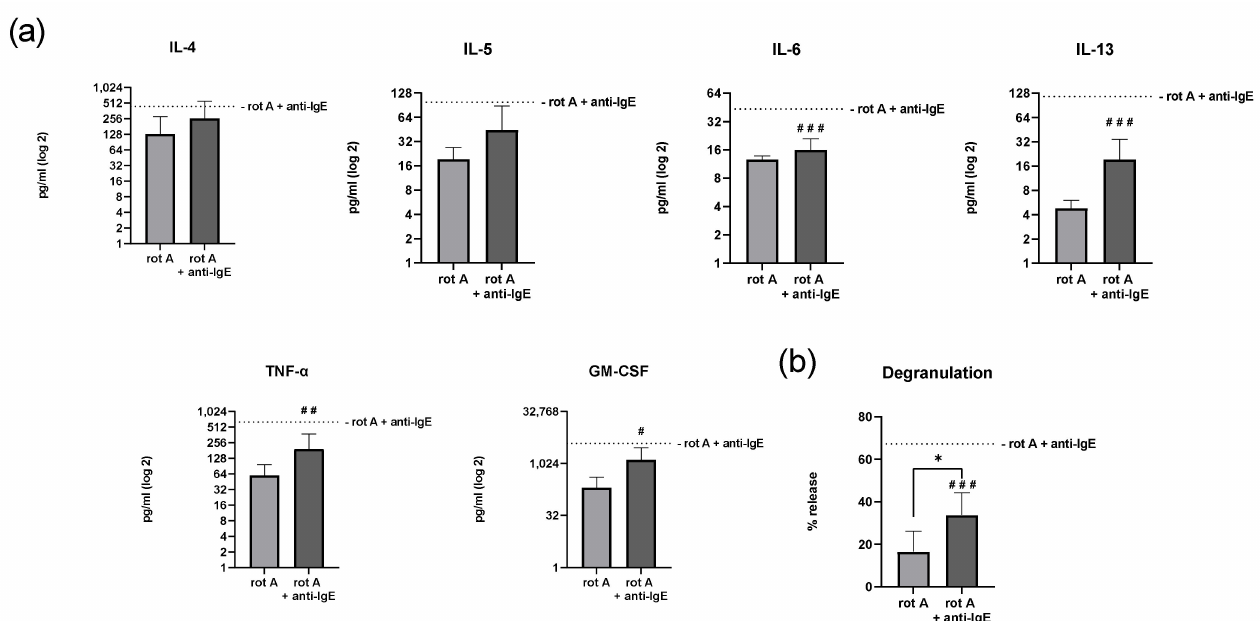
Figure 6. The inhibition of complex I of the respiratory chain significantly reduces degranulation and selectively attenuates anti-IgE-mediated secretion of IL-6, IL-13, TNF- α , and GM-CSF, but not of IL-4 and IL-5, of human skin MCs. After the inhibition of complex I using rotenone A (rot A), IgE-mediated stimulation (anti-IgE), the human skin MCs’ cytokine and growth factor secretion ( n = 5; ( a )) and degranulation ( n = 6; ( b )) were analyzed under glucose-free conditions ( a , b : mean ± SEM, paired Student’s t -test: * p < 0.05; one sample t -test of rot A and anti-IgE-treated MCs compared to the mean value of anti-IgE-treated control cells without rot A as indicated by the dotted line: # p < 0.05, ## p < 0.01, ### p < 0.001). anti-IgE = IgE-pretreated cells cross-linked with